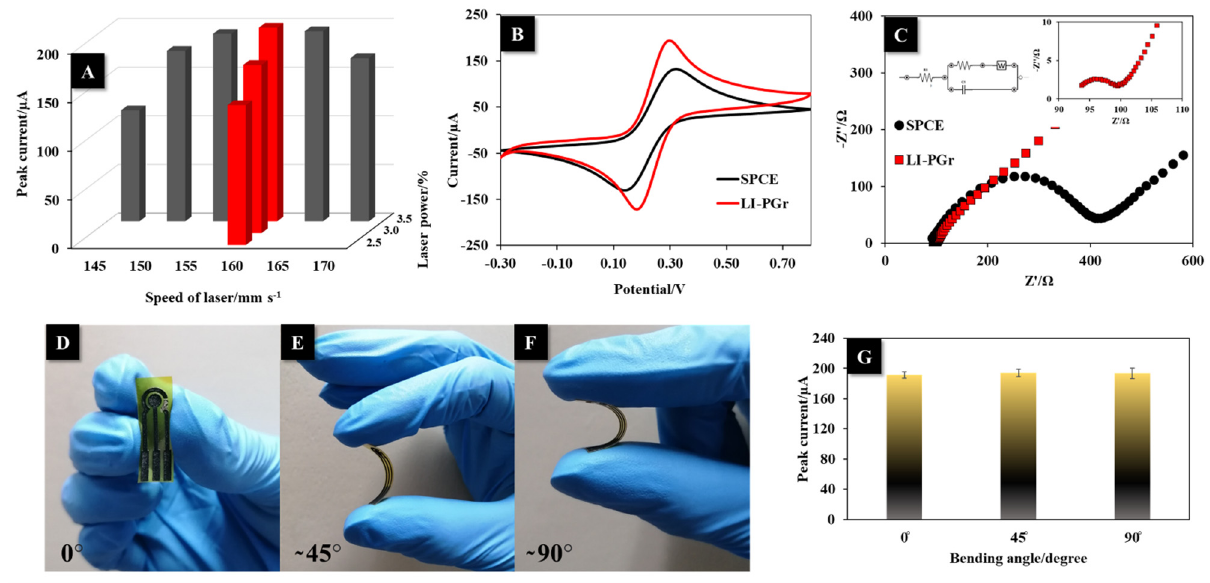
Figure 3. ( A ) The effects of laser speed and power on the fabrication of the laser-induced porous electrode were evaluated via the peak current response of 5.0 mM ferric/ferrocyanide ([Fe(CN) 6 ] 3 − /4 − ). ( B ) CVs of a commercial SPCE and the LI-PGr electrode in ferric/ferrocyanide (5.0 mM) at 50 mV s − 1 . ( C ) EIS spectra of a commercial SPCE and the LI-PGr electrode in ferric/ferrocyanide (5.0 mM) were produced at frequencies between 5.0 × 10 4 Hz and 5.0 × 10 − 2 Hz. Photographs are of the LI-PGr before bending ( D ) and after bending ( E ) at ~45° and ( F ) ~90°. ( G ) Effects of bending on the electrochemical performance of the LI-PGr electrode.